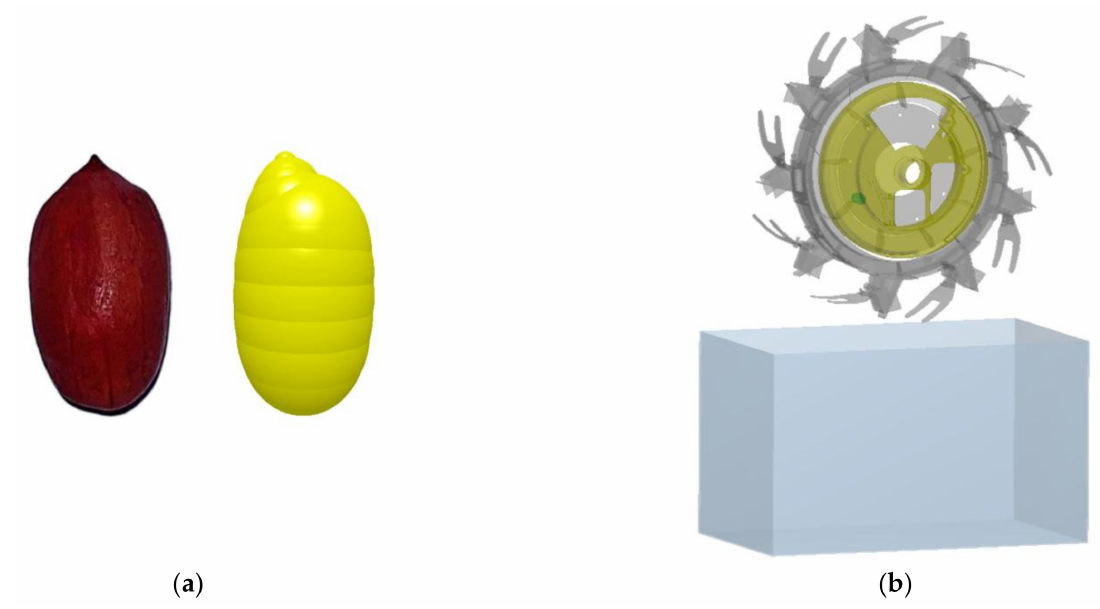
Figure 5. Simulation models: ( a ) seed model; ( b ) dibbler